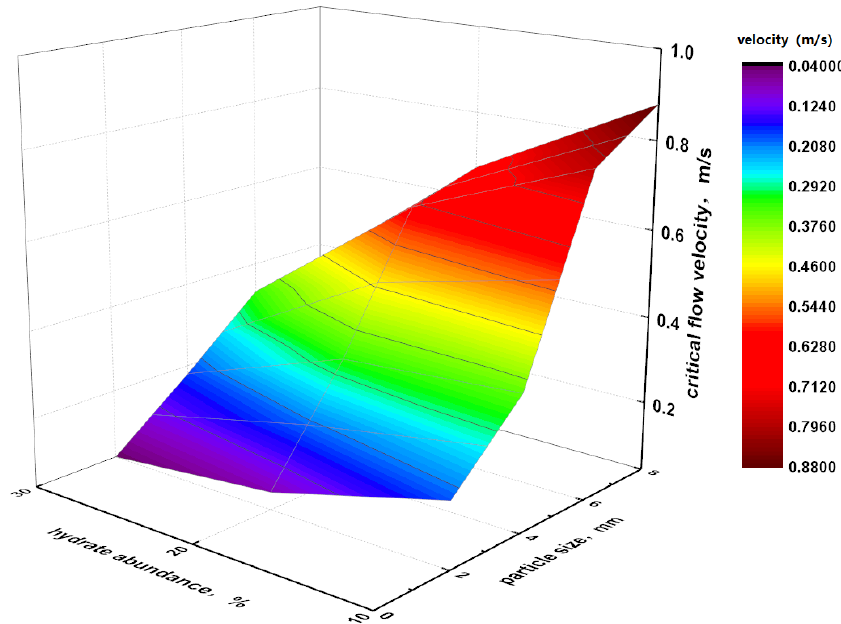
Figure 9. The critical flow velocity plate of different hydrate abundance and particle size under arc expansion.